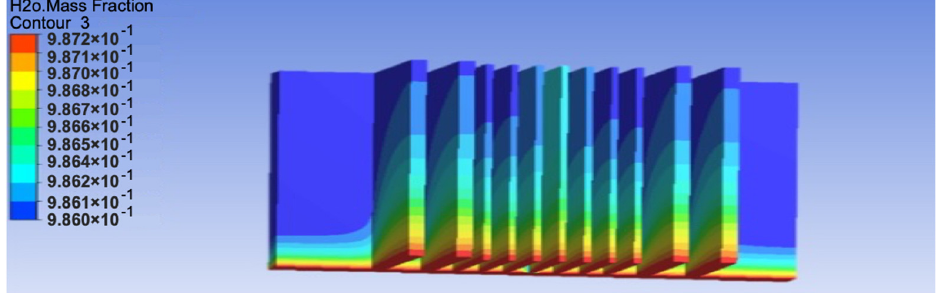
Figure 8. Mass fraction of water for the numerical model.